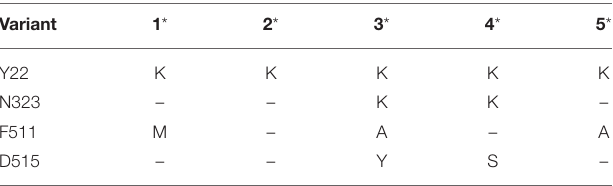
TABLE 4 | Top five variants predicted to alter MetH specificity in efforts to mimic the reaction catalyzed by Mtr.